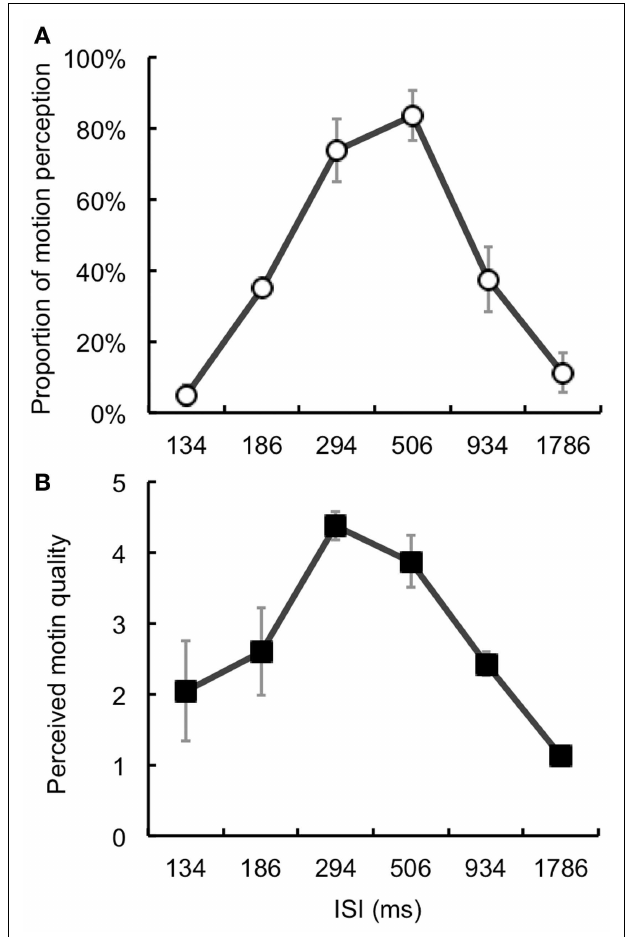
FIGURE 4 | Results of Section “Experiment 3.” (A) Proportion of illusory motion perception for the target. (B) Perceived motion quality.The values peaked with ISIs of 294 and 506ms.We also confirmed a significant positive correlation between these values ( r = 0.83). Error bars denote standard errors of the mean ( N =